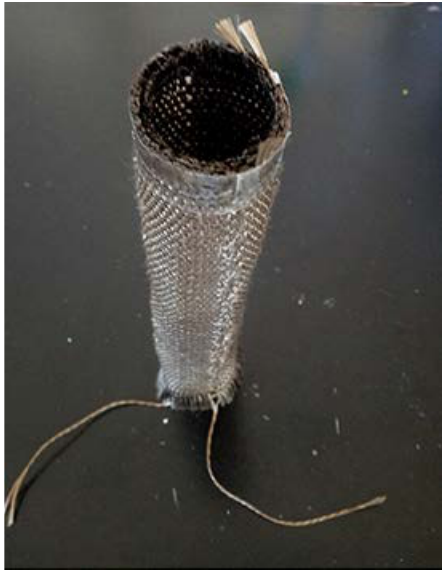
Figure 4. Preform image of the 3D tubular woven preform after its removal from the loom.